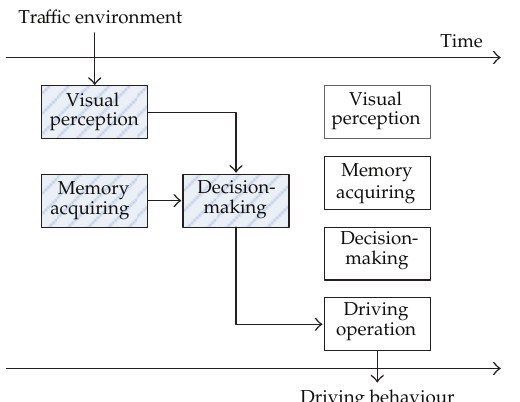
Figure 3: The cognition process of the